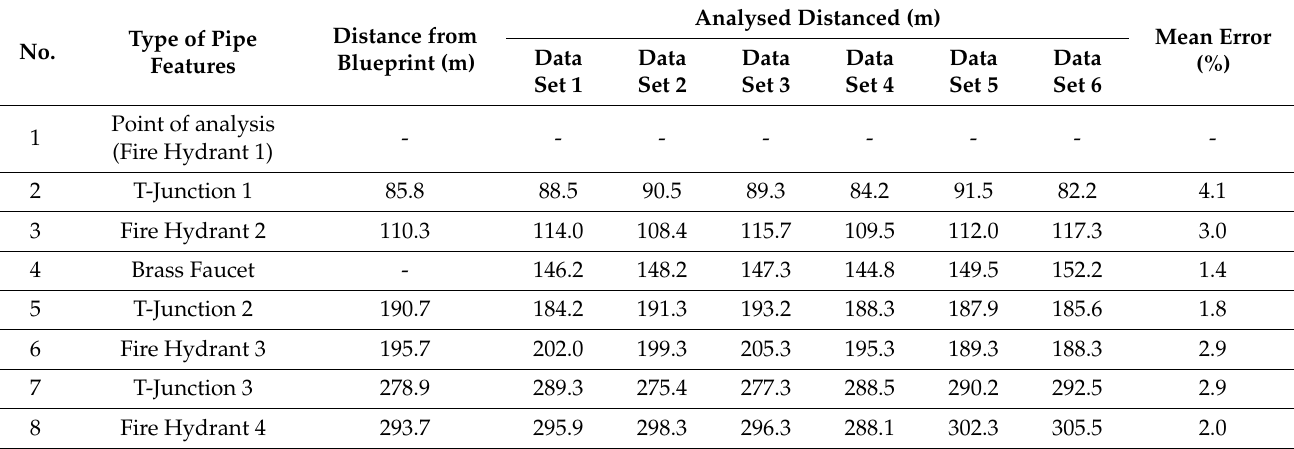
Figure 24. Brass faucet tapping directly to the service pipe. Table 4. NIKAZ evaluation for no-leak condition pipeline